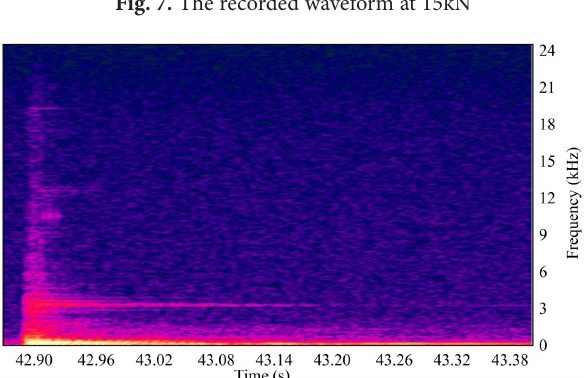
Fig. 7. The recorded waveform at 15kN